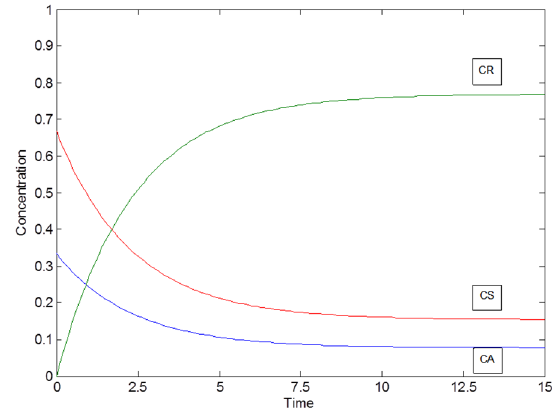
Figure 7. Concentration profiles of the special case of a parallel reaction system with parameters: k 1 = 1, K 1 = 10 and K 2 = 2.